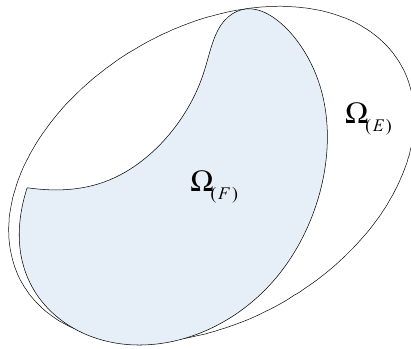
Ω is the non-ellipsoidal search space with ( ) F